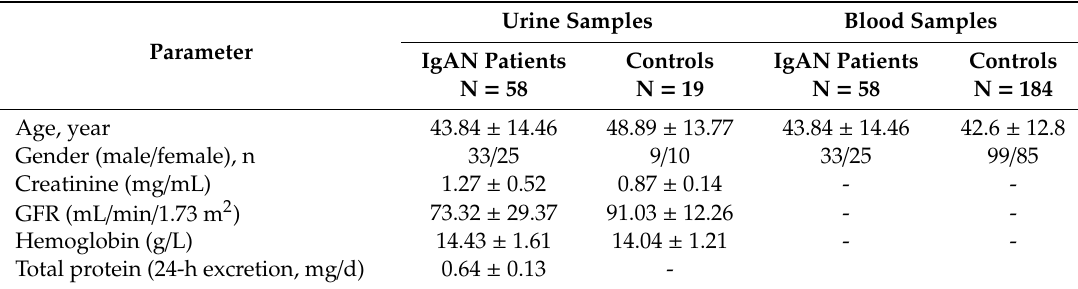
Table 1. Characteristics of IgAN patients and controls. Urine samples were collected for OPN concentrationmeasurement. Bloodsampleswerecollectedforgenotypingof SPP1